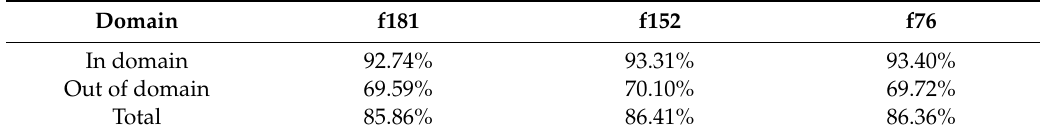
Table 4. Translation performance evaluation and feature